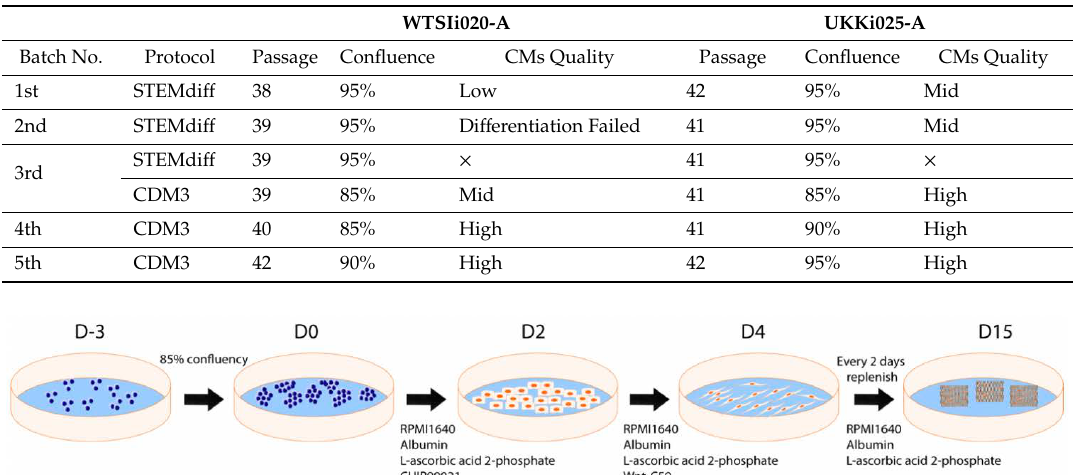
Table 3. Di ff erentiation protocol comparison. The STEMdi ff and CDM3 protocols were compared to di ff erentiate cardiomyocytes (CMs) using two hiPSC-lines, one from a healthy patient (WTSIi020-A) and